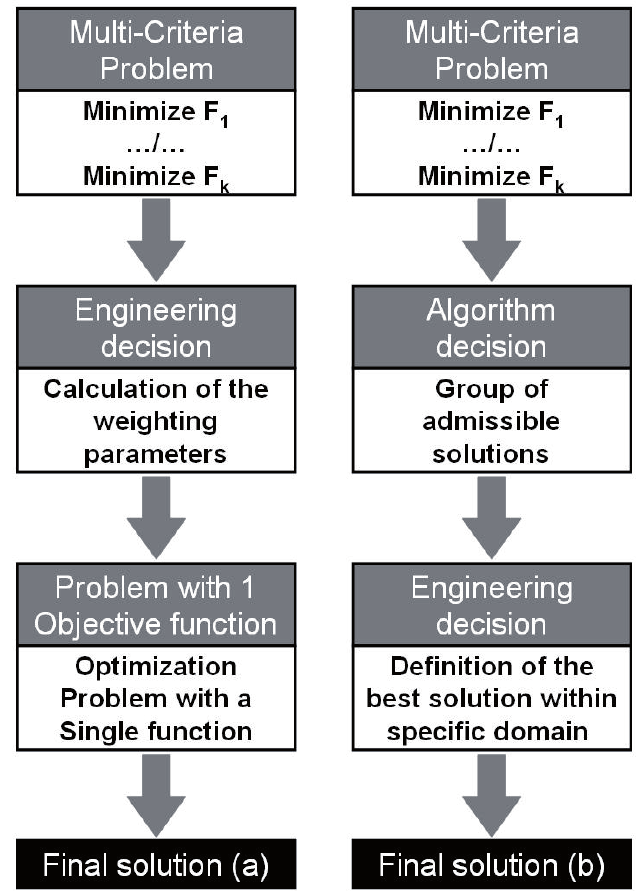
Fig. 3. Direct (a) and Posteriori (b) methods for multi- objective